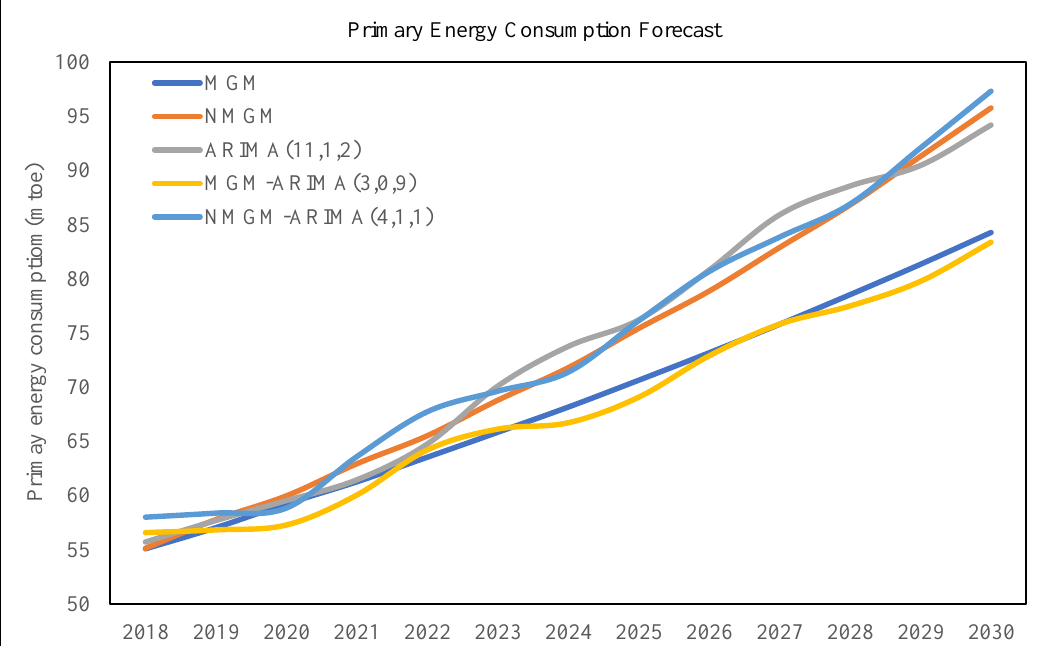
Figure 12. Outcomes of five models for predicting future primary energy consumption in East Africa.